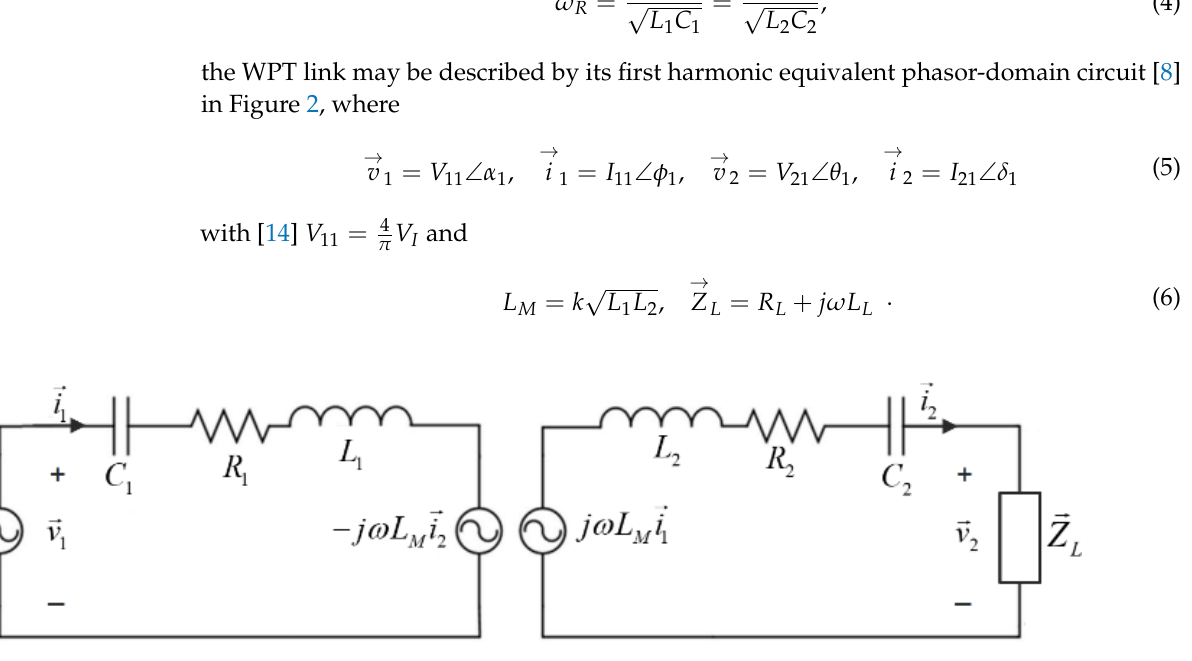
Figure 2. Equivalent phasor-domain circuit.